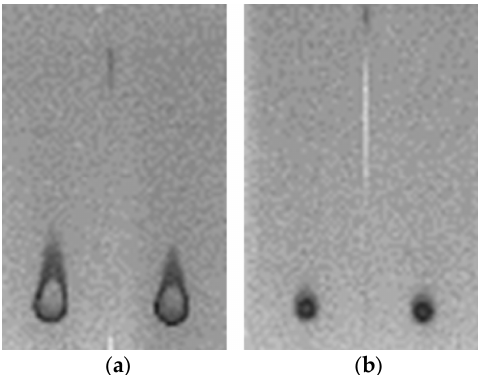
Figure 2. ( a ) Alexa 488 fluorescent dye was run on thin-layer chromatography (TLC) plates, each 2.5 cm × 7.5 cm; ( b ) Conversely, the Alexa 488 of PCSN probes remained at the initial spot.